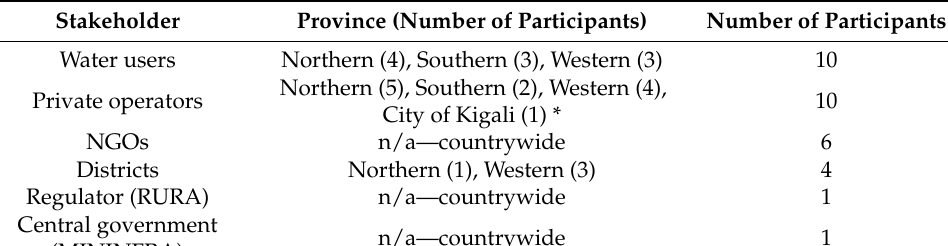
Table 1. Stakeholders who were interviewed in the study (NGOs—non-governmental organizations, RURA—Rwanda Utilities Regulatory Authority, MININFRA—Ministry of Infrastructure). * Two PO participants worked across two districts, and one was based in the City of Kigali.